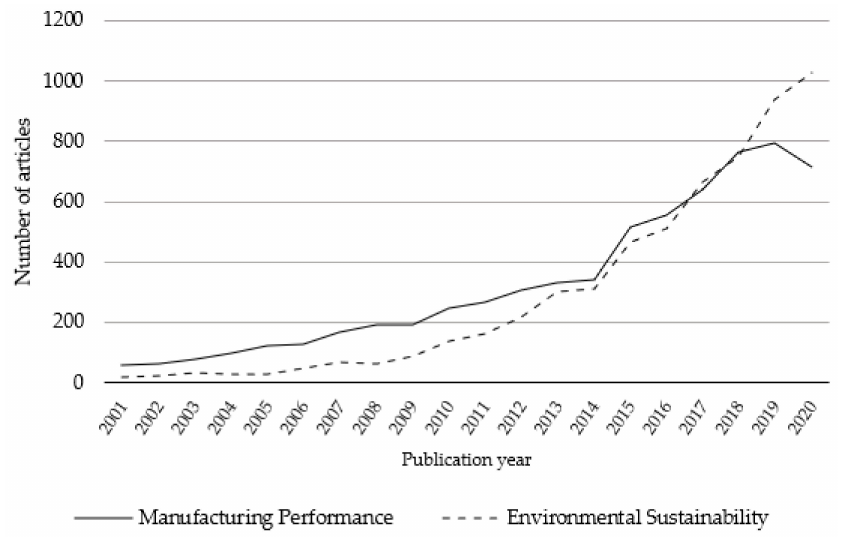
Figure 3. Publication trends for manufacturing enterprise performance (MEP) and environmental sustainability (ES) over the past 20